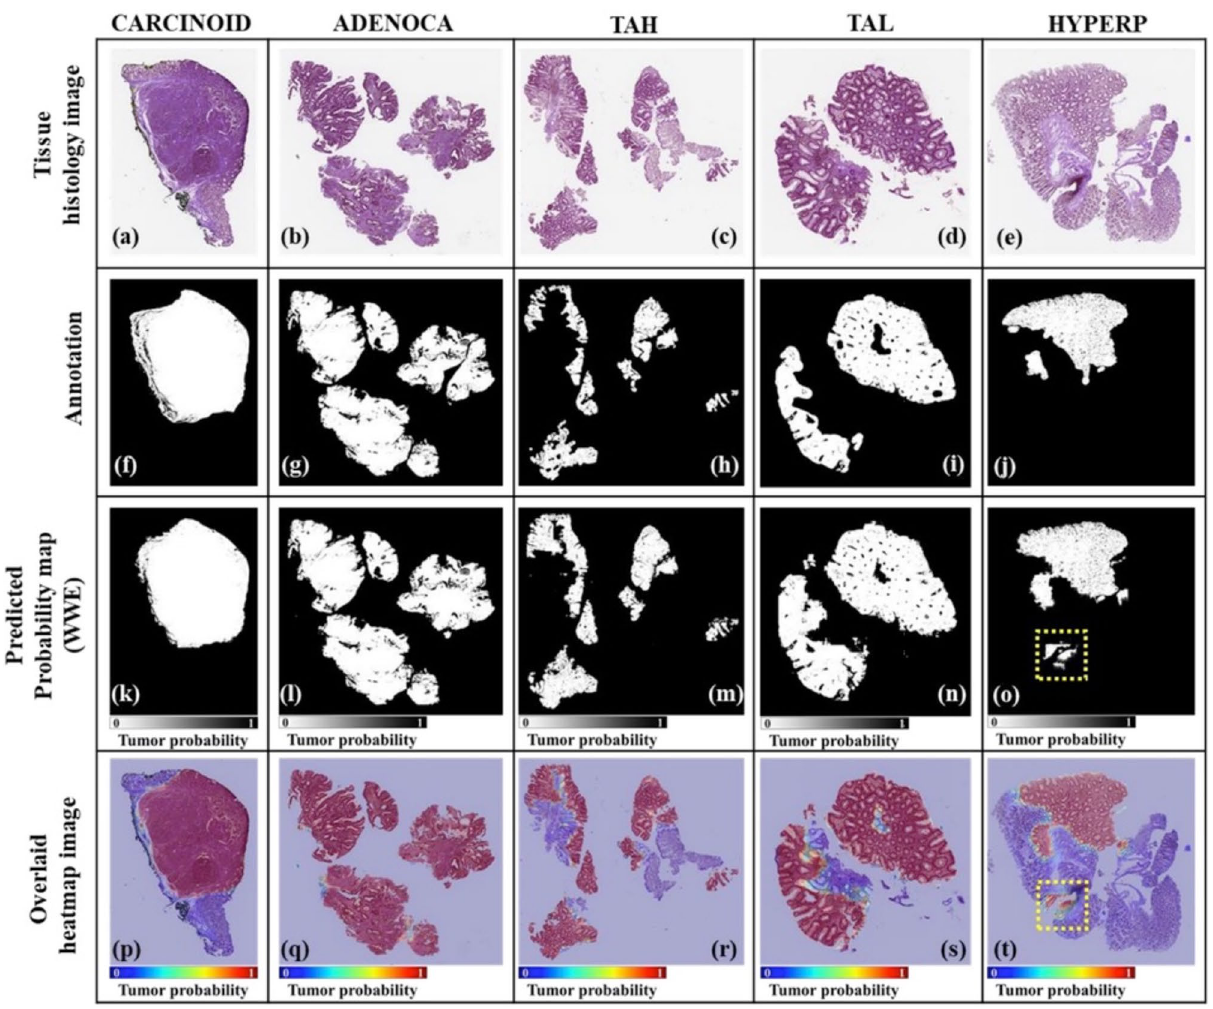
Figure 5. Prediction results of the five different tumor classes. ( a )–( e ) are tissue histology images. ( f )–( j ) are annotation by a pathologist (i.e., ground truth). ( k )–( o ) are predicted probability map (WWE). ( p )–( t ) are overlaid tissue histology image and prediction heatmap. Yellow dotted boxes in ( o ) and ( t ) show misprediction due to dead nuclei.